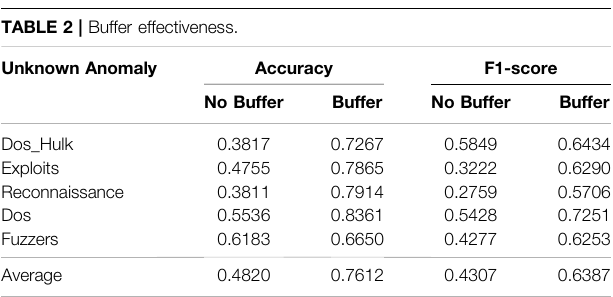
TABLE 2 | Buffer effectiveness.